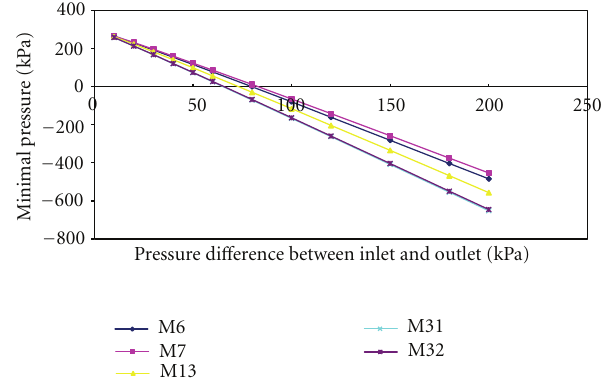
Figure 3: Lines of pressure di ff erences and minimum pressure of Venturi